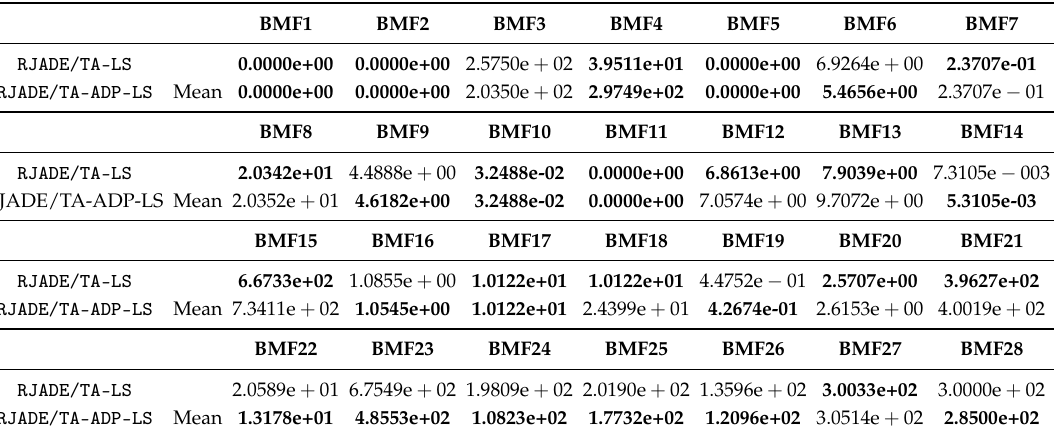
Table 3. Comparing RJADE/TA-ADP-LS with RJADE/TA-LS. BMF1 BMF2 BMF3 BMF4 BMF5 BMF6 BMF7